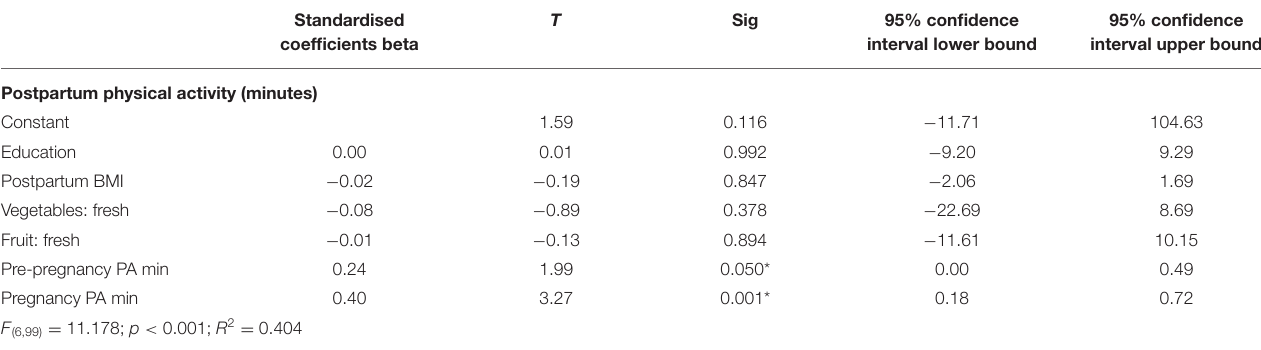
TABLE 4 | Linear regression analysis for postpartum physical activity against education level, post-partum BMI, Fresh vegetable and fruit intake, pre-pregnancy physical activity, pregnancy physical